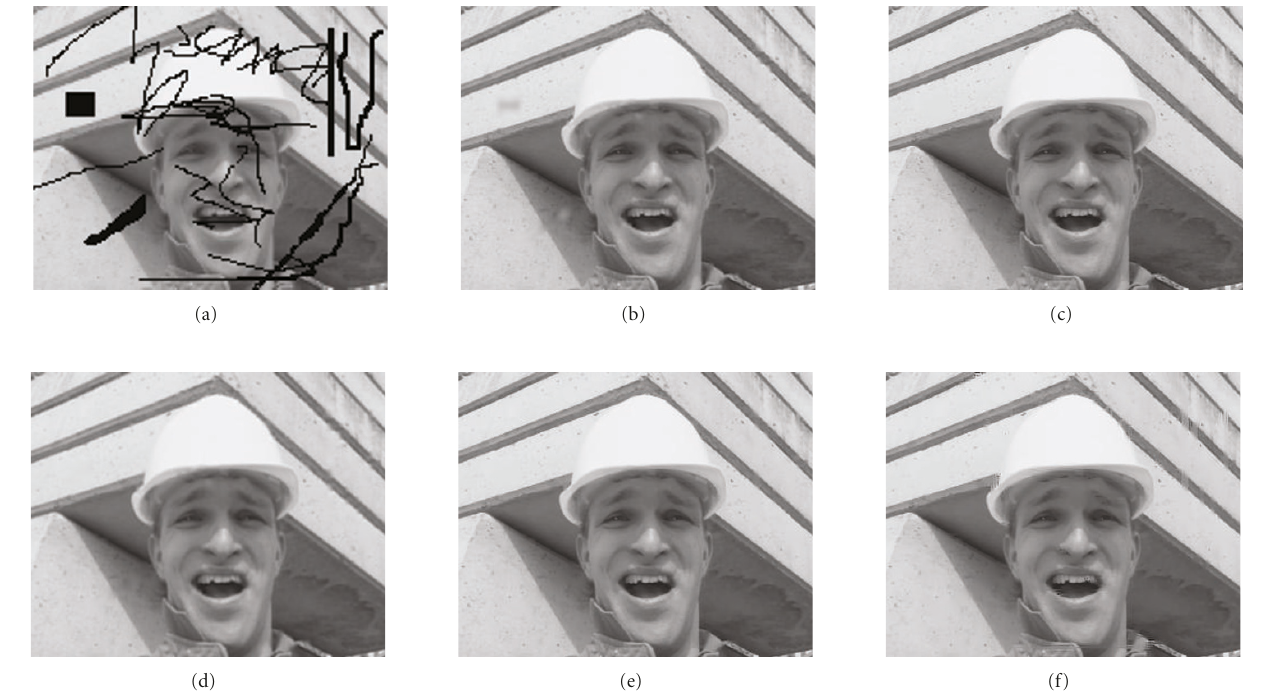
Figure 8: Experimental results in the synthetic “missing” case. (a) LR frame, (b) Laplacian simultaneous inpainting and SR result with λ = 0 . 008192, (c) TV simultaneous inpainting and SR result with λ 2 λ = 0 . 065536, (e) TV simultaneous inpainting and SR result with λ 2 with λ 2 = 0 .